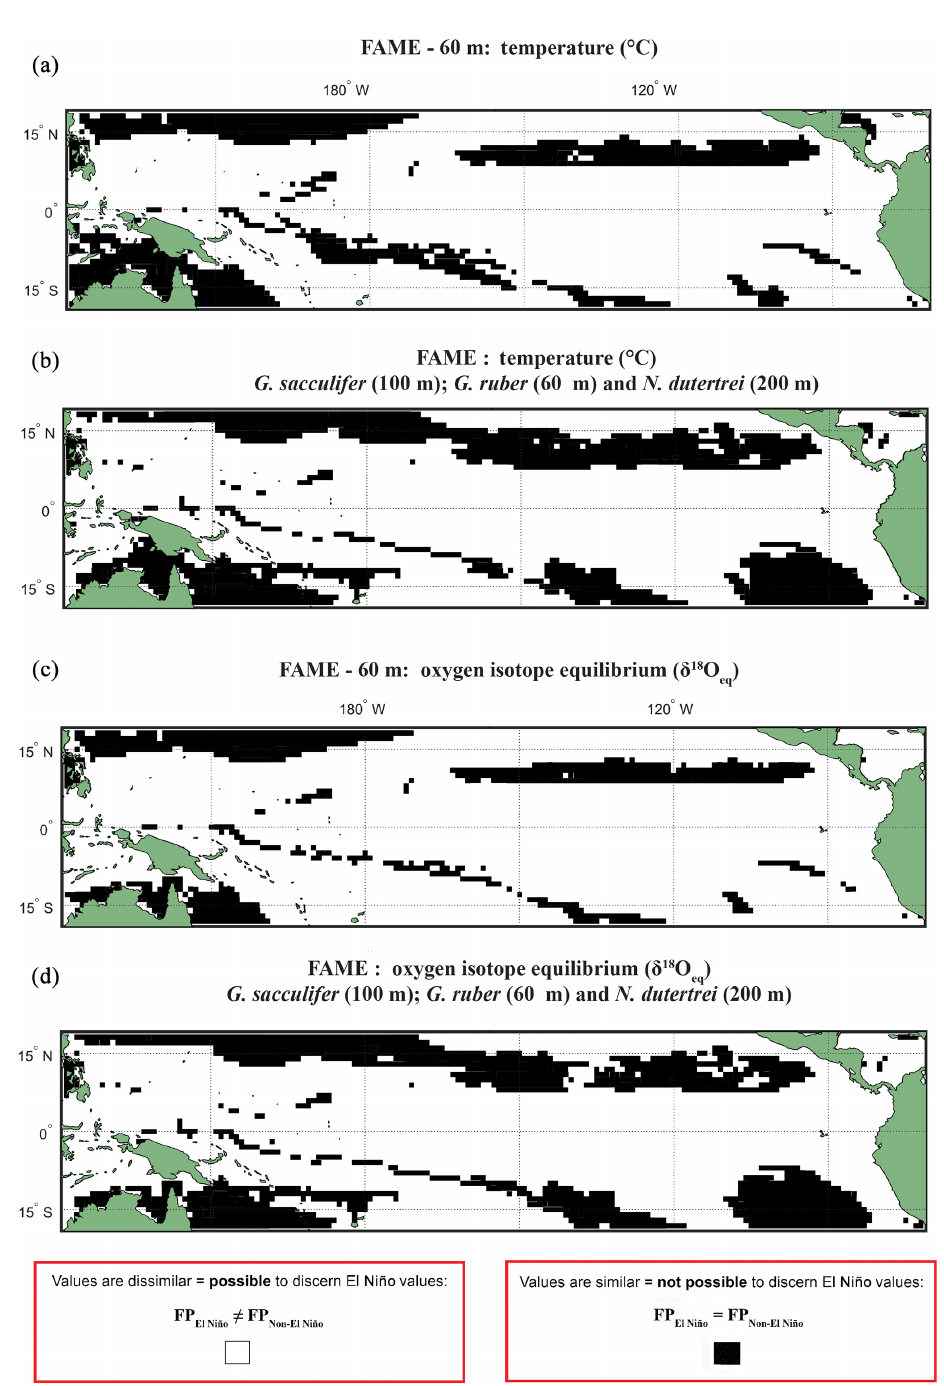
Figure 2. Anderson–Darling results plotted regionally in which species-specific results are overlain, for each plot the results represent where at least one species shows that it may not be possible to discern El Niño Values. Panels represent water depth locations where dissimilar and similar values for the two climate states for (a, b) FAME T c modelled temperature and (c, d) FAME δ 18 O c modelled oxygen isotope values recorded in the calcite shells ( T c ) occur. Each panel represents the Anderson–Darling test result. The results for Globigerinoides sacculifer , Globigerinoides ruber , and N. dutertrei are overlaid with (a, c) cut-off depth of 60m and (b, d) species-specific cut-off values. For all panels, black areas reflect latitudinal and longitudinal grid points that failed to reject the null hypothesis (H 0 ), and therefore the foraminiferal population (FP) of the El Niño is similar to the non-El Niño. Therefore the distribution between the neutral climate and El Niño cannot be said to be different (FP ElNiño = FP Non-ElNiño